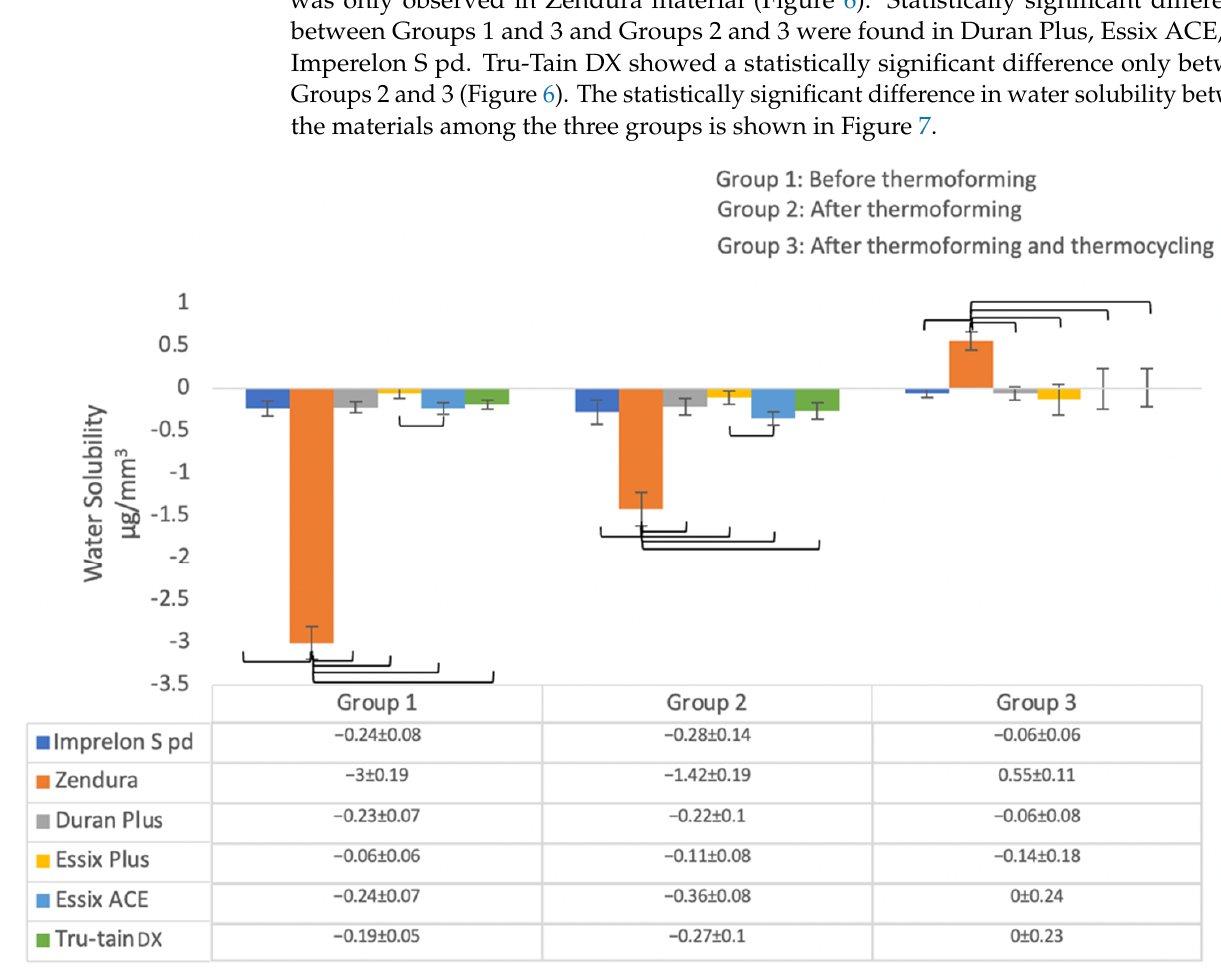
Figure 7. Comparison of the water solubility between the investigated materials. Materials connected by a solid black line have a significant difference at ( p < 0.05).